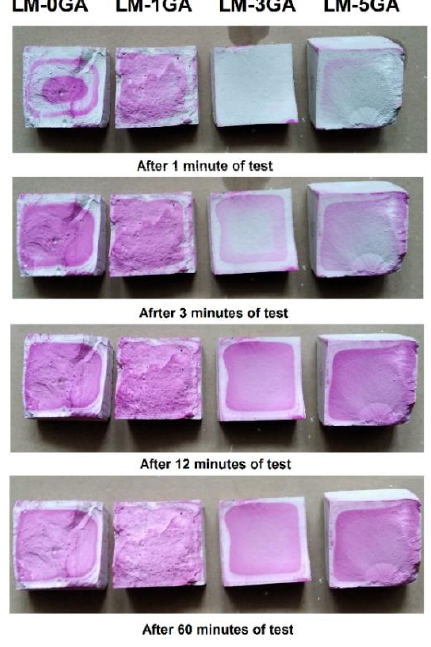
Figure 11. Progress of carbonation of the tested pastes. Table 5. Bulk density of hemp concretes (average values) and the standard deviation.